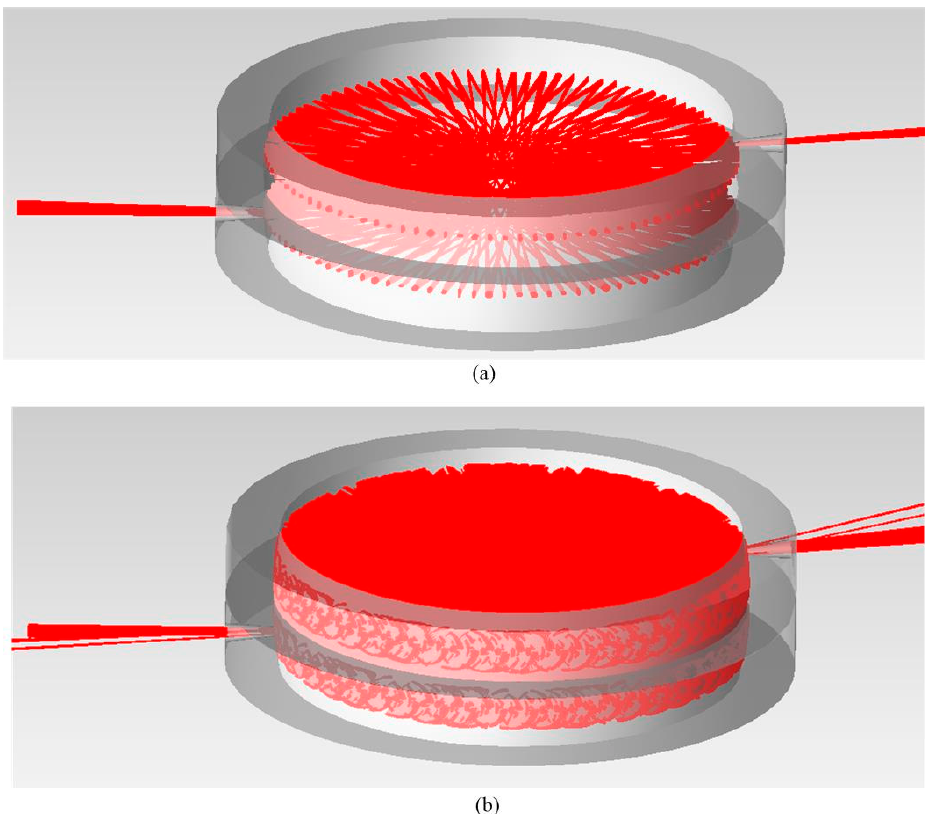
Figure 4. Simulation cases with parameters of R = 100 mm, p = 98 and q = 47 (upper limit calculated by Equation (38) is 6.477 mm) and ( a ) c = 6.4 mm, within the upper limit; ( b ) c = 6.5 mm, beyond the upper limit. The initial diameter of the beam is 6 mm, the incident focal length is 203.2 mm and the total number of rays that are traced in the simulation is 2611.